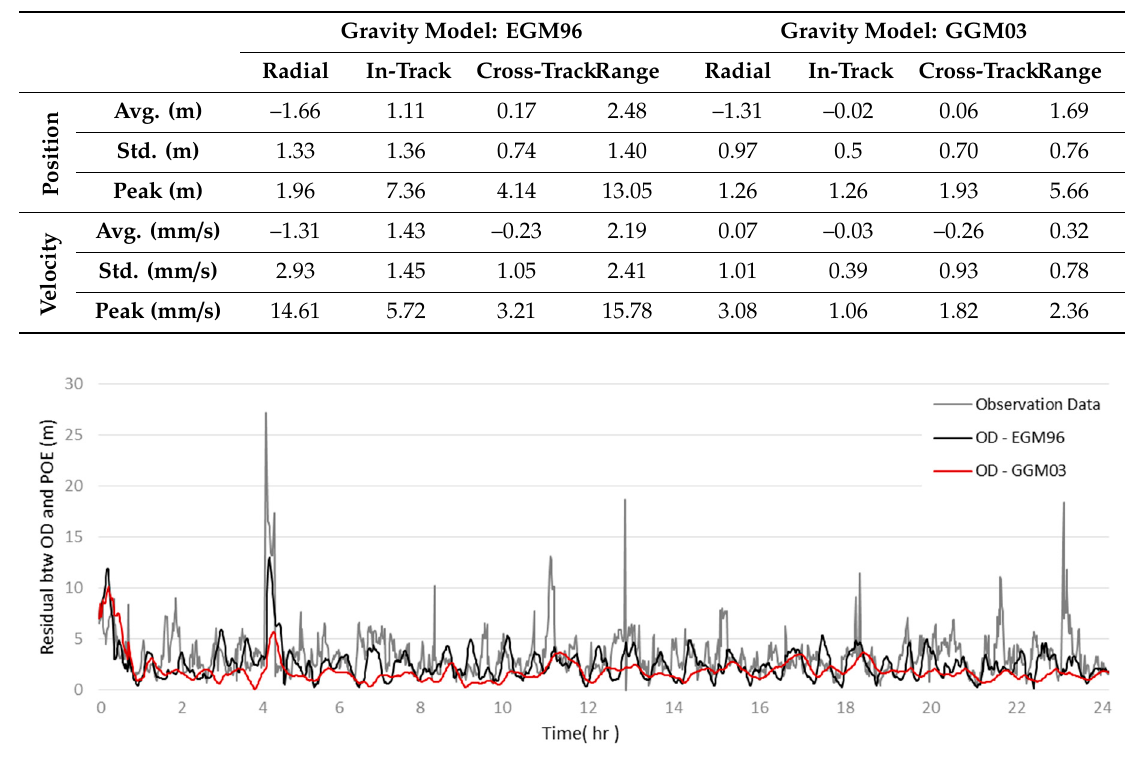
Figure 11. Superiority and inferiority of the gravity model when performing orbit determination logic. The accuracy of orbit determination logic improved after applying GGM03, and local maximum errors, which are seriously affected by the ionospheric time delay, were also reduced successfully. Table 5. Summary of orbit model including gravity and non-gravity models. The orbit model was operated practically in the on-board real-time orbit determination logic of GPS-12.